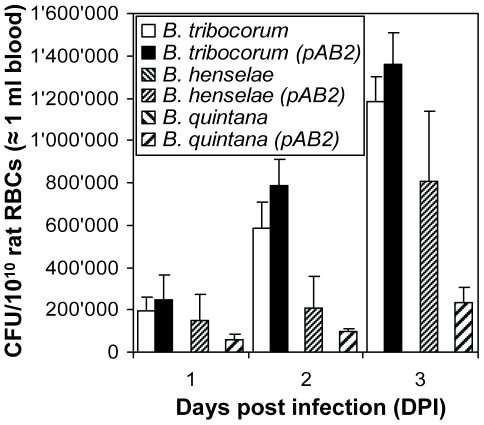
Role of Trw T4SS in mediating host-specific erythrocyte invasion.Freshly isolated rat erythrocytes were infected with B. tribocorum, B. tribocorum (pAB2), B. henselae, B. henselae (pAB2), B. quintana, or B. quintana (pAB2) at a MOI = 1. Intra-erythrocytic bacteria were enumerated at 1, 2 and 3 days post infection (DPI) by the gentamicin protection assay (n = 3; mean +/−SD).